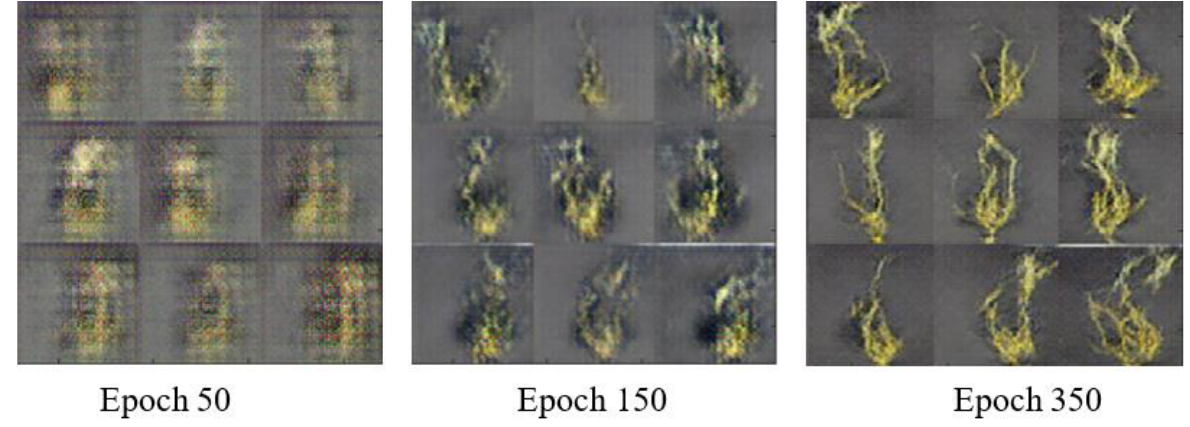
Figure 6. Synthetic ARR-affected pea root images generated by GAN model during the training process.